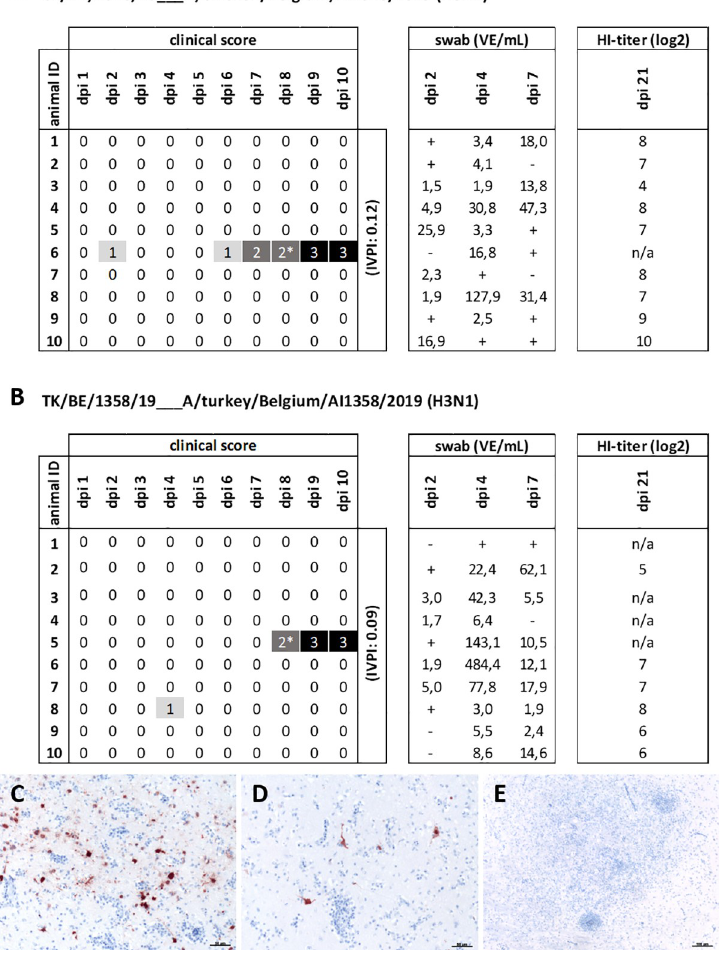
Fig 1. Intravenous infection of chickens with Belgian H3N1 isolates: Clinical course, HI-titers, and virus antigen detection. Chicken were infected intravenously (i.v.) with either (A) CK/DE/1940/19 or (B) DK/BE/1358/19 H3N1 isolate. The clinical status was monitored over a period of ten days post inoculation (dpi). Clinical status is recorded as healthy (0), birds showing slight (1) or severe disturbances of the general condition (2). In both groups, one animal showed neurological signs including torticollis and was euthanized, as indicated with asterisk. Subsequently they were recorded as dead (3). The IVPI is the mean score per bird per observation over the 10-day period (1 observation per bird per day). In addition, virus shedding was measured and presented here as infectious virus equivalents (VE) per ml, calculated on basis of cq values from combined oro-pharyngeal swabs and correlated to a standard curve of stock virus with known infectivity titer. VE below 1 are indicated with (+) and VE of 0 are indicated with (-). Finally, antibody HI-titers of sera were determined three weeks after infection. Viral matrix protein detection in the (C) brain stem and (D) cerebral cortex after i.v. infection with CK/BE/1940/19. (E) No antigen detection following i.v. TK/BE/ 1358/19 infection, despite significant inflammatory infiltration. Influenza virus matrix protein was detected by immunohistochemistry, using the ABC method, AEC as chromogen (red) and counterstained by haematoxylin (blue). Bar = 50 μ m (C, D) and 100 μ m (E).